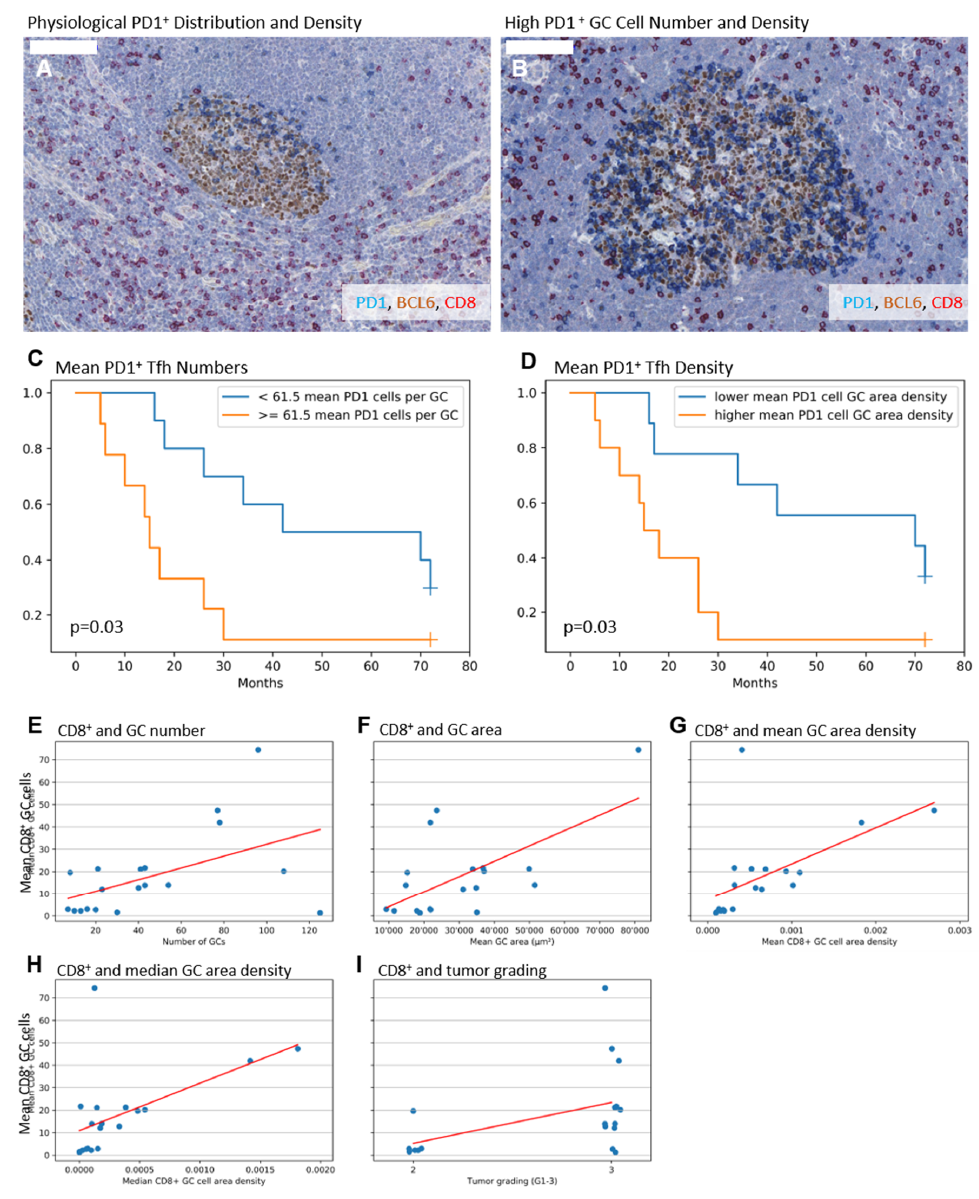
Figure 1. ( A,B ) Exemplary immunohistochemical triple stainings showing BCL6 + germinal centers (GCs, brown), PD1 + T-follicular helper cells (Tfh, blue), and CD8 + cytotoxic T-cells (red); 100µm indicated by white bar in the upper left, respectively. ( A ) Exemplary GC with polarized PD1 + Tfh distribution, lower PD1 + Tfh number and lower area density. ( B ) Exemplary GC with non-polarized PD1 + Tfh distribution, higher PD1 + Tfh number and higher area density. ( C – E ) Separation of groups by mean split. ( C ) Mean PD1 + Tfh number ≥ 61.5 cells per GC is associated with lower survival ( p = 0.03, logrank test, 15 deaths for 72 months follow-up observation time, 1 patient still alive in the PD1 high group, 3 patients still alive in the PD1 low group after 72 months follow-up). ( D ) Mean density ≥ 0.002475 PD1 + Tfh per mm 2 GC area is associated with lower survival ( p = 0.03, logrank test, 15 deaths for 72 months follow-up observation time, 1 patient still alive in the PD1 high group, 3 patients still alive in the PD1 low group after 72 months follow-up). ( E – I ) Association between mean numbers of CD8 + GC cells, morphometrical, and clinical findings. ( E ) Higher mean numbers of CD8 + GC cells are associated with higher GC numbers, higher mean GC areas ( F ), higher mean and median CD8 + GC cell density ( G , H ), and higher tumor grade ( I